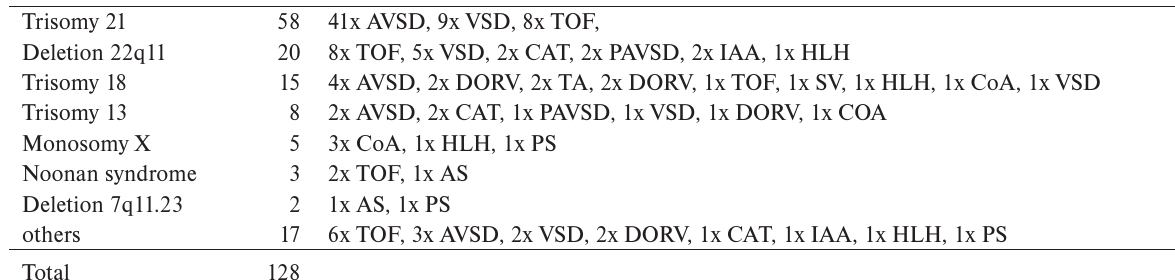
Fig. 4. (B) Postnatally diagnosed CHDs, n (%). Table 2. Genetic pathologies and types of observed